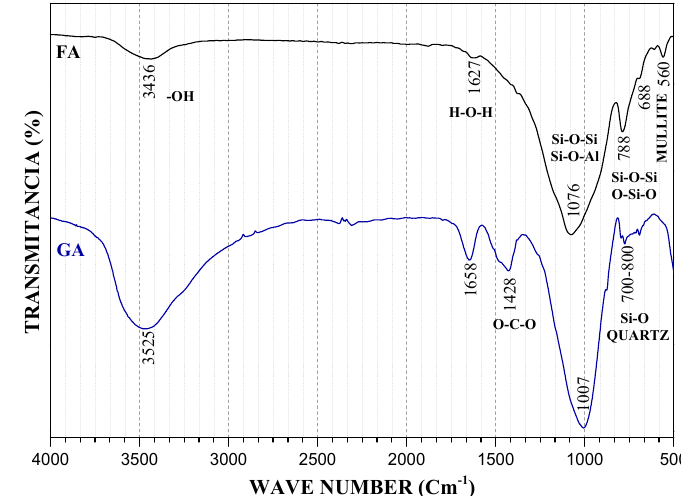
Figure 5. FT ‐ IR spectrum of FA and GA.